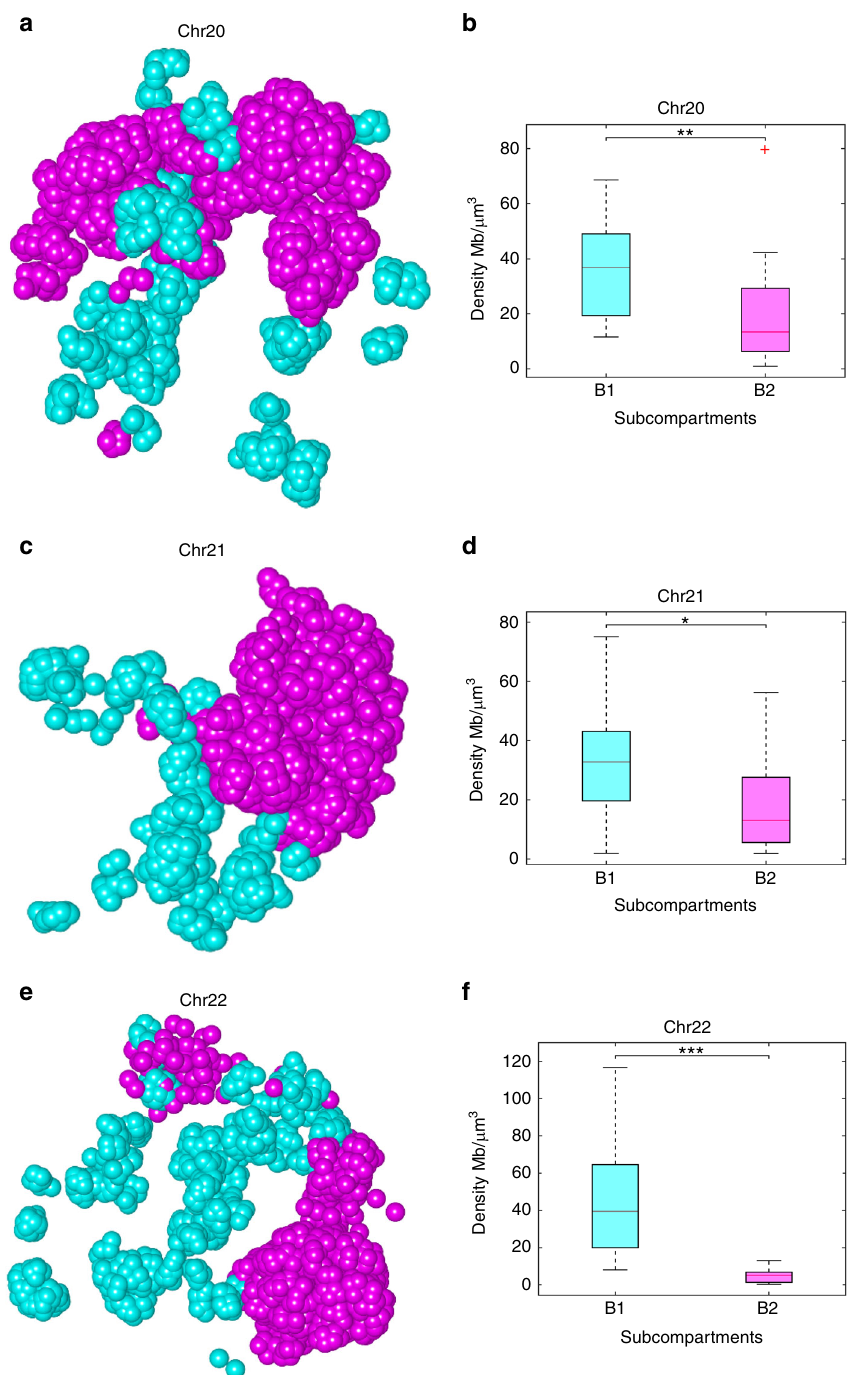
Fig. 5 Regions belonging to the same subcompartment tend to colocalize in the 3D space. a , c , e Visualization of the regions belonging to subcompartments B1 (cyan) and B2 (magenta) in the 5 Kbps-resolution 3D models reconstructed by GEM-FISH for Chr20, Chr21, and Chr22, respectively. Only regions that belong to either B1 or B2 are shown. The visualization was performed using UCSF Chimera 61 . b , d , f Boxplots on the densities of regions belonging to subcompartments B1 and B2 for Chr20, Chr21, and Chr22, respectively. N B 1 = 39, 20, 44 genomic segments belonging to subcompartment B1 for Chrs 20, 21, and 22, respectively. N B 2 = 23, 25, 9 genomic segments belonging to subcompartment B2 for Chrs 20, 21, and 22, respectively. * p -value < 0.007, **p-value < 10 − 4 , ***p-value< 10 − 4 . All tests were performed using the one-tailed Wilcoxon rank-sum test. For the boxplots, the top and bottom lines of each box represent the 75th and 25th percentiles of the samples, respectively. The line inside each box represents the median of the samples. The upper and lower lines above and below the boxes are the whiskers. Red points marked by ‘ + ’ represent outliers, which represent the observations beyond 1.5 times interquartile range away from the top or the bottom of the